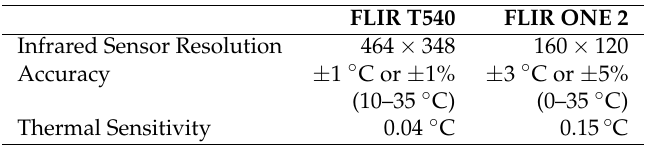
Table 2. Specification of FLIR T540 and FLIR